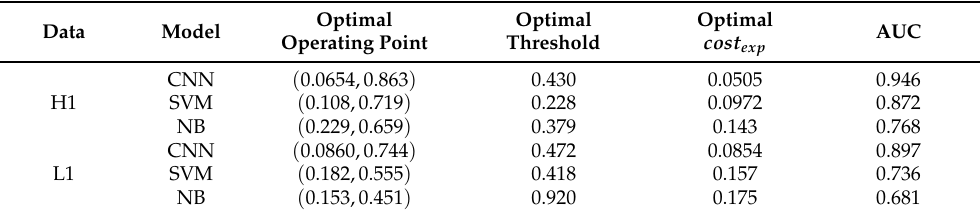
Table 4. Additional metrics that were computed from ROC curves in Figure 11. From the area under the ROC curve (AUC), we have that, for both datasets, the CNN has the best performance (the highest AUC value), followed by the SVM with a middle performance, and finally by the NB classifier with the worst performance. Notice that, for the CNN, better performance does not mean an optimal threshold that is closer to the default 0.5